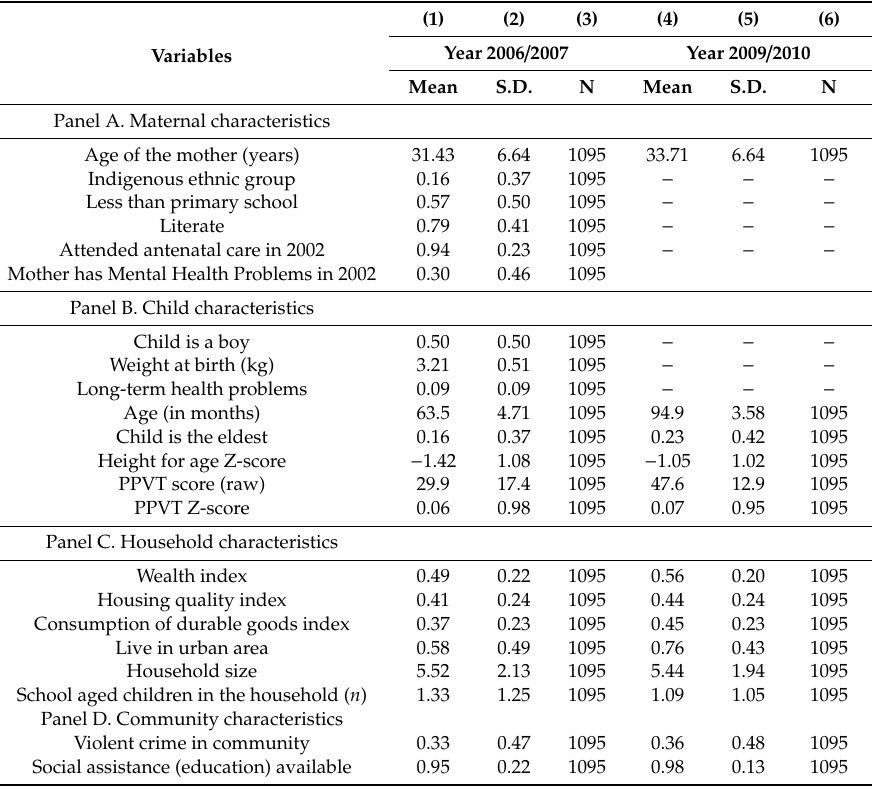
Table1presentsummarystatistics(meanandstandarddeviation)ofthevariablesusedintheanalysis.Thesevariables are available in the first three rounds of the Peruvian Young Lives Survey. The sample is restricted to children with available information on maternal mental health in 2002 and PPVT scores in 2006 and